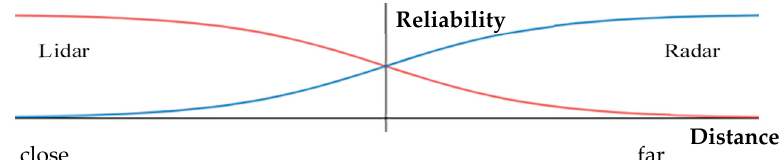
Figure 7. Reliability function; the x-axis is the distance of the opponent vehicle from the ego vehicle. The y-axis represents the reliability of the value measured by the sensor. When comparing the two sensors, the lidar was accurate at close range, and the radar was accurate at long distances.